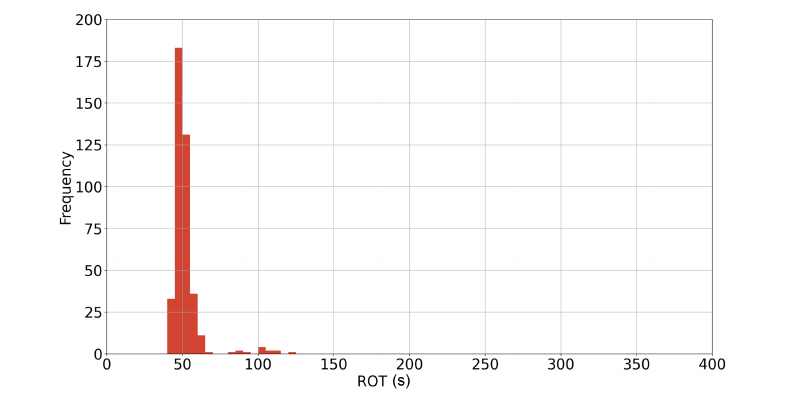
Figure 10. Runway occupancy time (ROT).